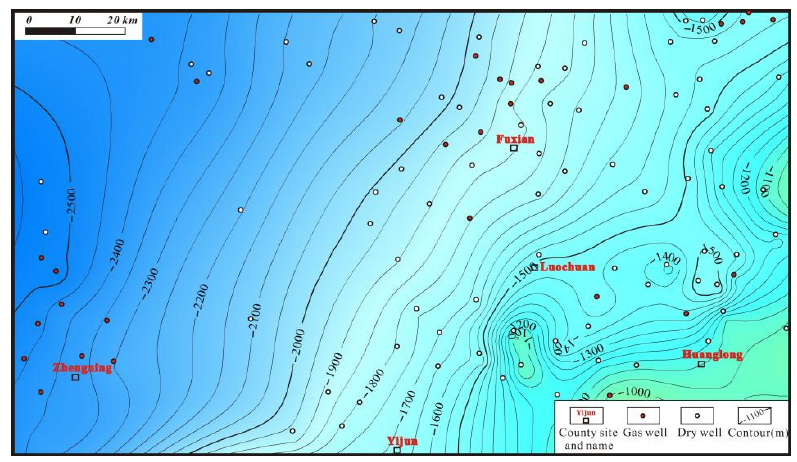
Figure 6. Structural map of the Taiyuan Fm. in the southeastern Ordos Basin.